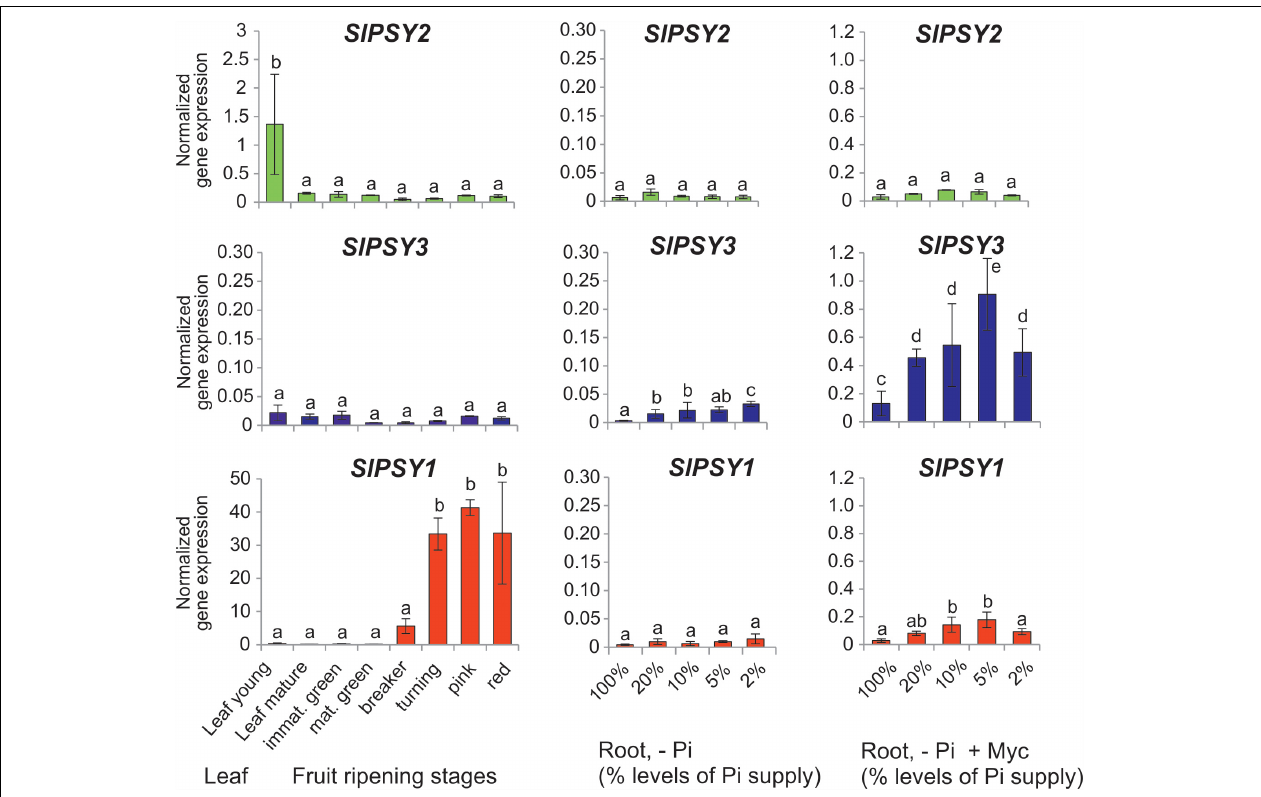
FIGURE 3 | Normalized transcript levels of PSY isogenes from S. lycopersicum in phosphate-starved roots with and without mycorrhization and in other organs. Roots were harvested after 6 weeks of cultivation on expanded clay under phosphate starvation (– Pi, center panels) or mycorrhizal conditions under various phosphate starvation regimes (– Pi + Myc, right panels). Leaf and ripening fruit samples (left panels) were taken from soil-grown plants. The housekeeping gene SlPSY2 is presented on the top panels (green columns). SlPSY3 as the putative ortholog of MtPSY3 is presented in the center (blue columns). The special paralog of tomato ( SlPSY1 ) is shown on the bottom (red columns). Please note the individual adaptation of scales in the various data displays due to very high differences in transcript levels between the three PSYs and the various organs and treatments. However, the same scale has been maintained for the three genes in the – Pi and – P + Myc treatments of roots for better comparison. qRT-PCR data were normalized to constitutively expressed SlEF1 α . Error bars indicate SD from three to five biological replicates for the root samples and two replicates for the leaf and fruit samples. Different lower case letters indicate statistically different values in ANOVA followed by a Tukey HSD test ( p ≤